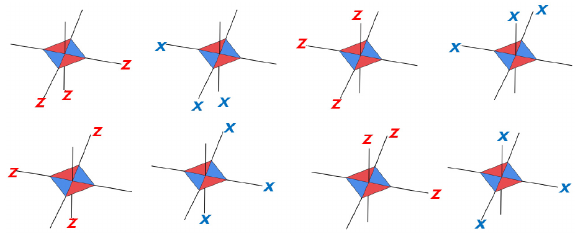
FIG. 17. Some unitary product stabilizers of the rank-6 tensor derived from the [[4, 2, 2]] encoding map. Identifying the two legs pointing up and down as the logical legs, these diagrams also produce the different representations of the logical operators